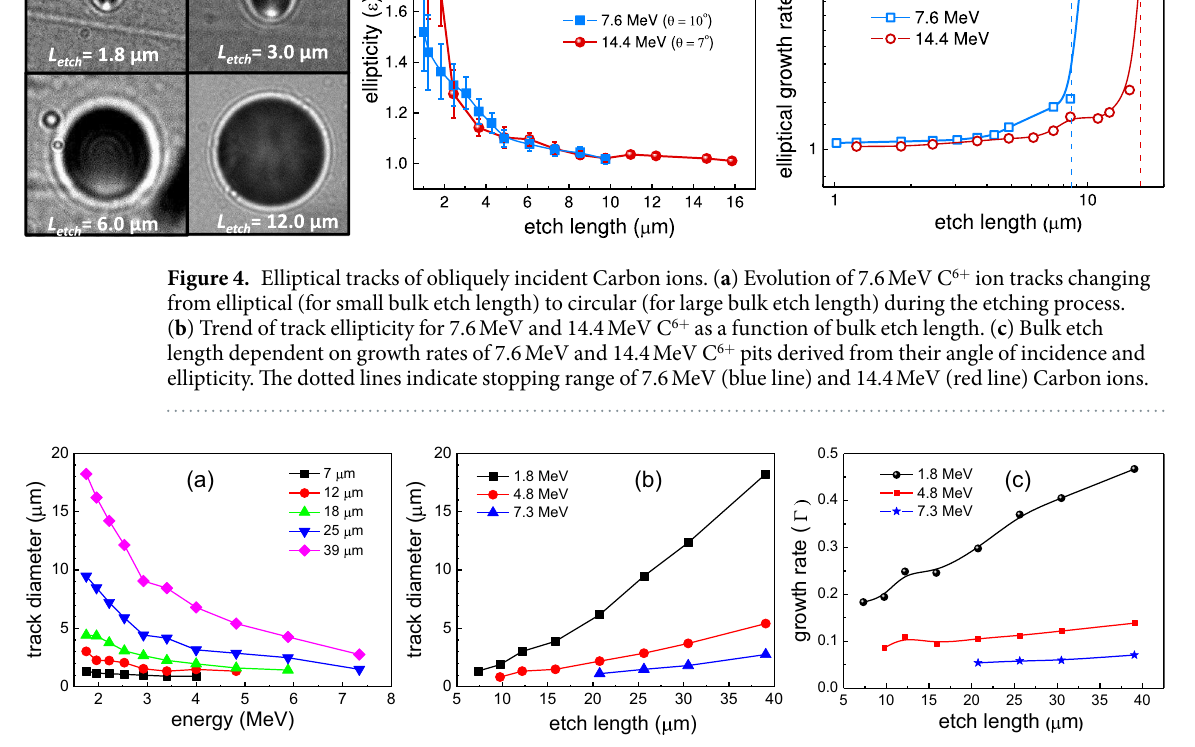
Figure 5. Evolution of the proton tracks. The track diameter variation of protons ( a ) for selected bulk etch length as a function of its energy and ( b ) for selected energies (1.8 MeV, 4.8 MeV and 7.3 MeV) as a function of bulk etch length. ( c ) Growth rate of the track diameter as a function of bulk etch